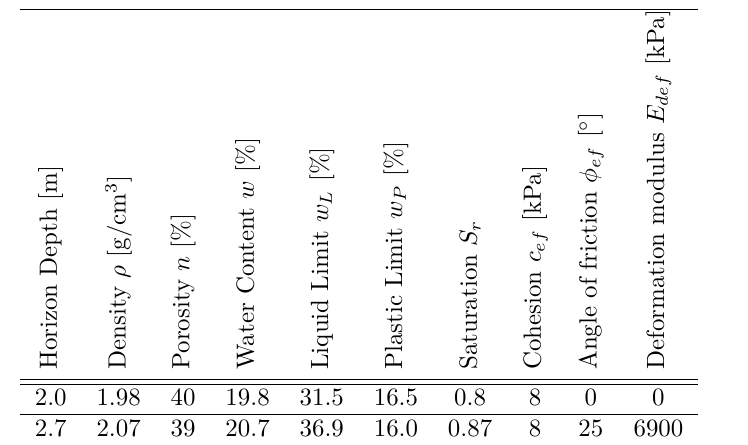
Table 1. The parameters of ground